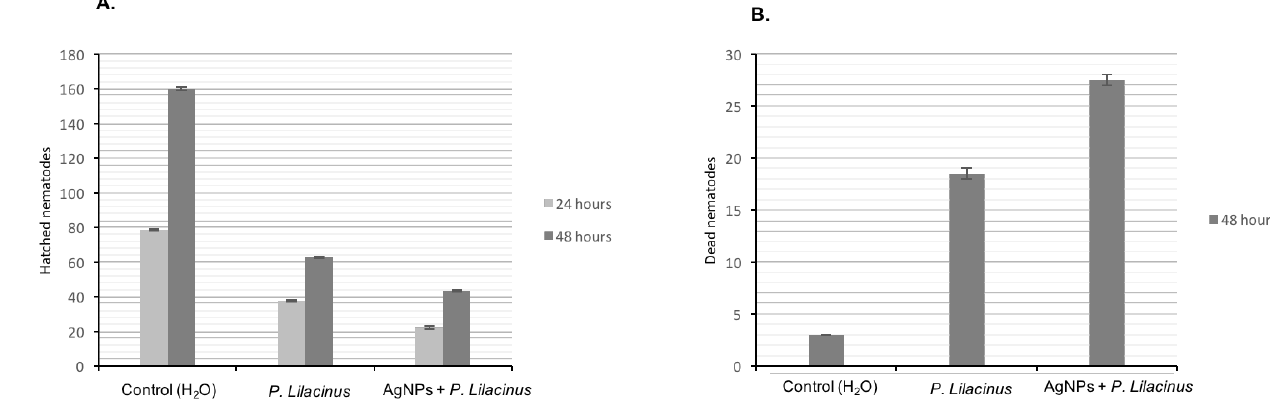
Figure 9. In vitro effect of P. lilacinum filtrate and biosynthesised AgNPs stabilised with this filtrate: ( A ) number of eggs hatching after 24 and 48 h, ( B ) number of dead M. incognita nematodes after 48 h.